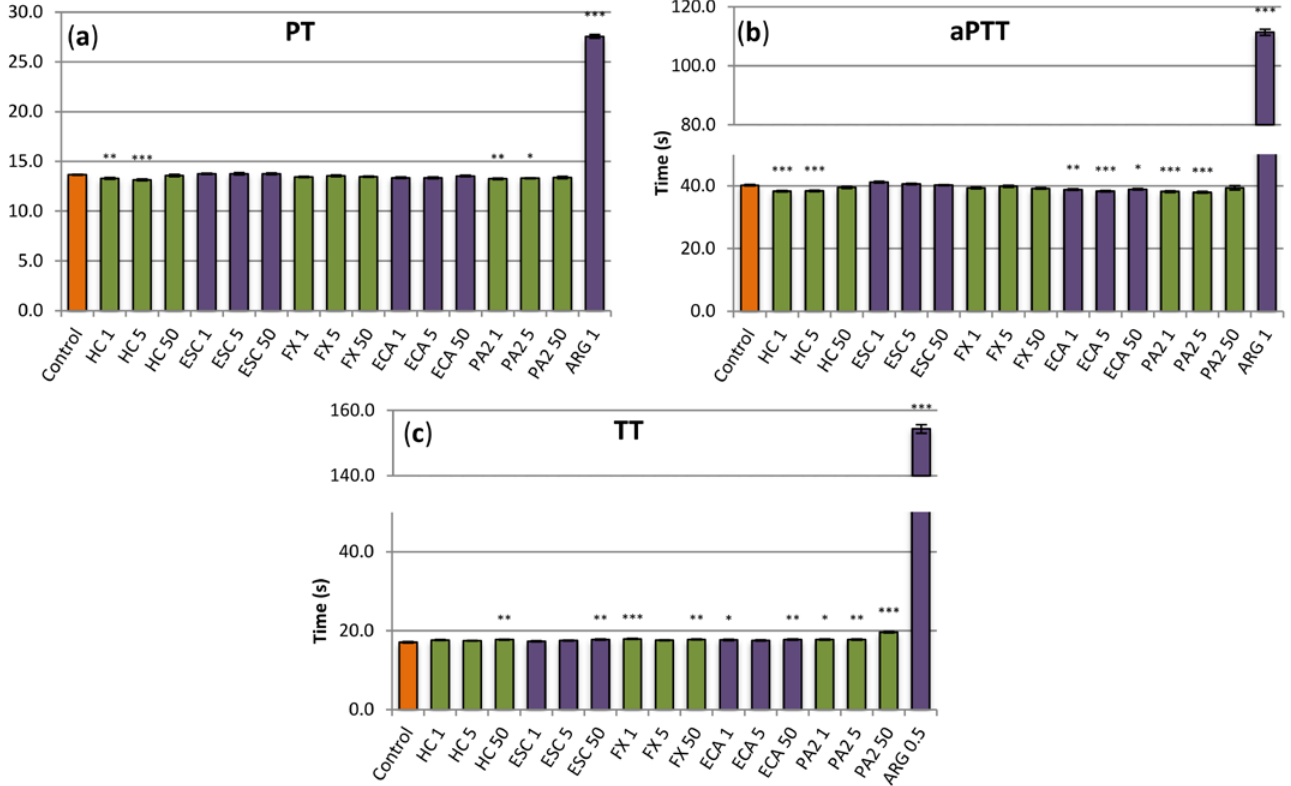
Figure 6. Effects of the investigated analytes on coagulation times, ( a ) prothrombin time (PT), ( b ), activated thromboplastin time (aPTT) and ( c ) thrombin time (TT). Results presented as means ± SE ( n = 10–12). Statistical differences: * p < 0.05, ** p < 0.01, *** p < 0.001 for control plasma versus plasma incubated with analytes. Analytes: HC, horse-chestnut bark extract; ESC, esculin; FX, fraxin, ECA , (‒) -epicatechin; PA2, procyanidin A2; ARG, argatroban; the numbers after analyte symbol indicate concentration in μ g/mL.